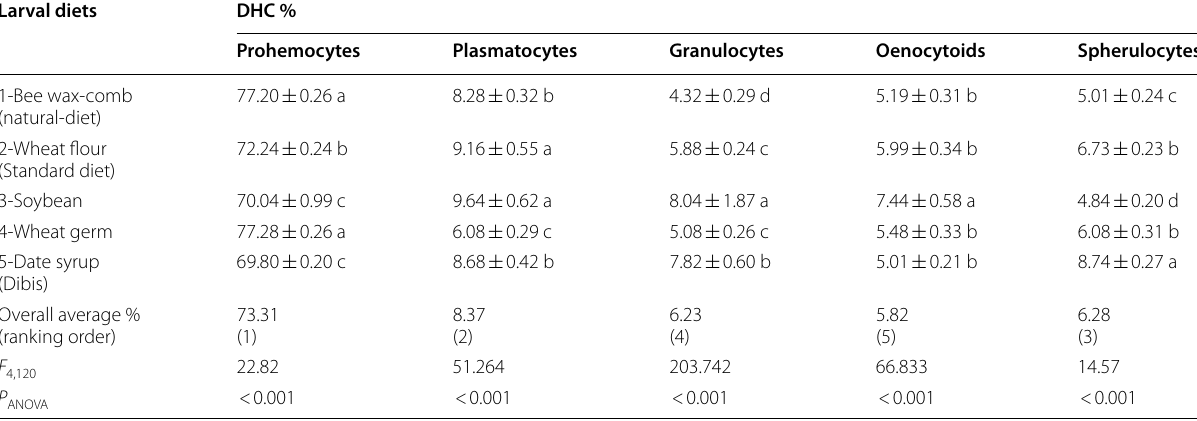
Means SE sharing the same small letters in the same columns are statistically insignificant ( p > 0.05) ±